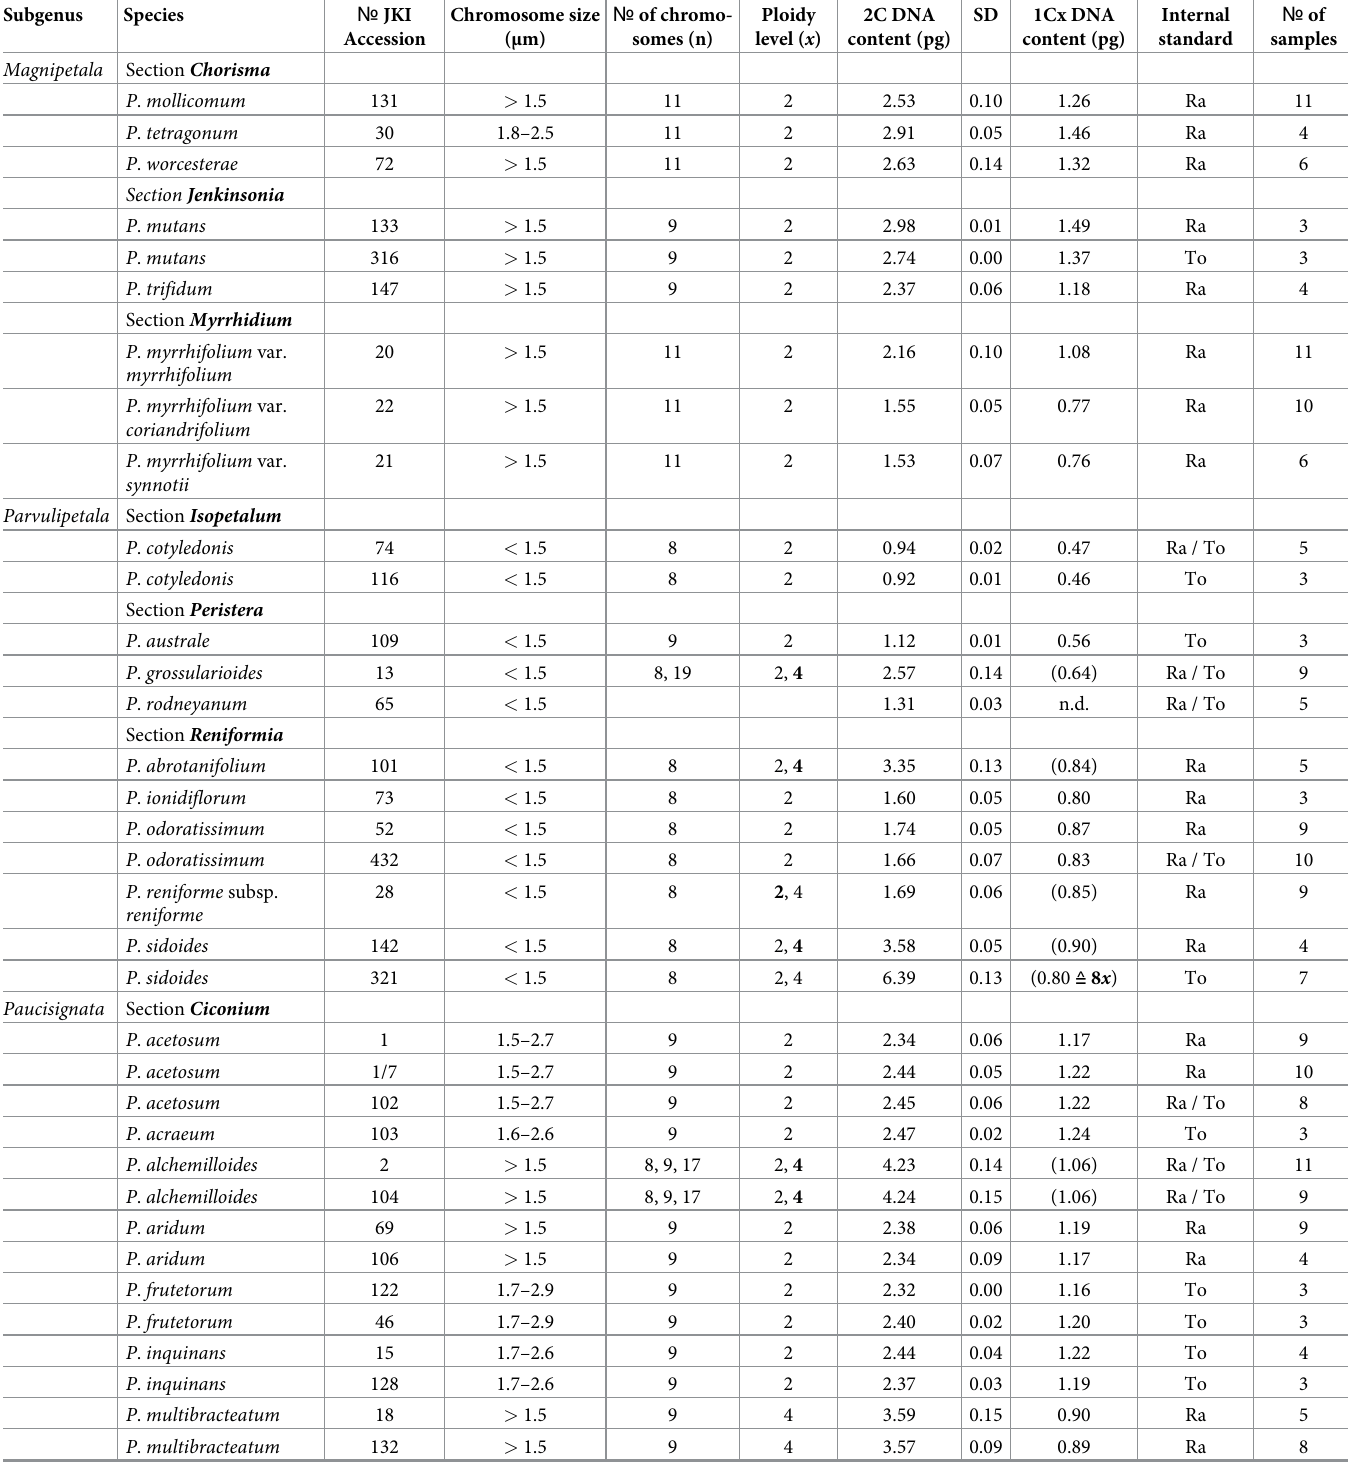
Table 1. Pelargonium species / accessions with JKI collection number for which the 2C DNA content was determined in this study. The assignment of sections is based on Ro¨schenbleck et al . [2]. Chromosome numbers, ploidy levels and chromosome lengths were obtained from the literature. 1C x DNA contents in brackets were